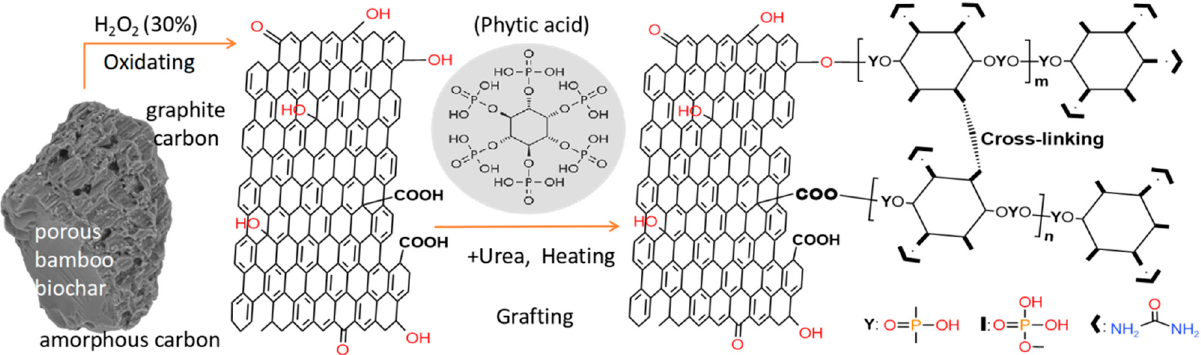
Figure 1. Schematic diagram of mBC fabrication.